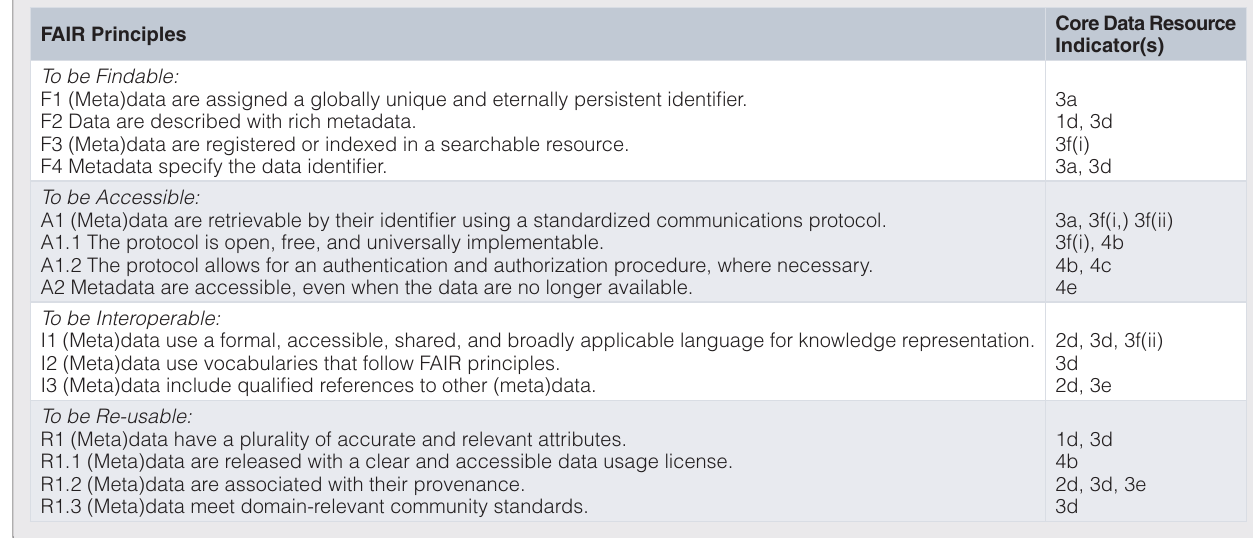
Core Data Resource Indicator(s)